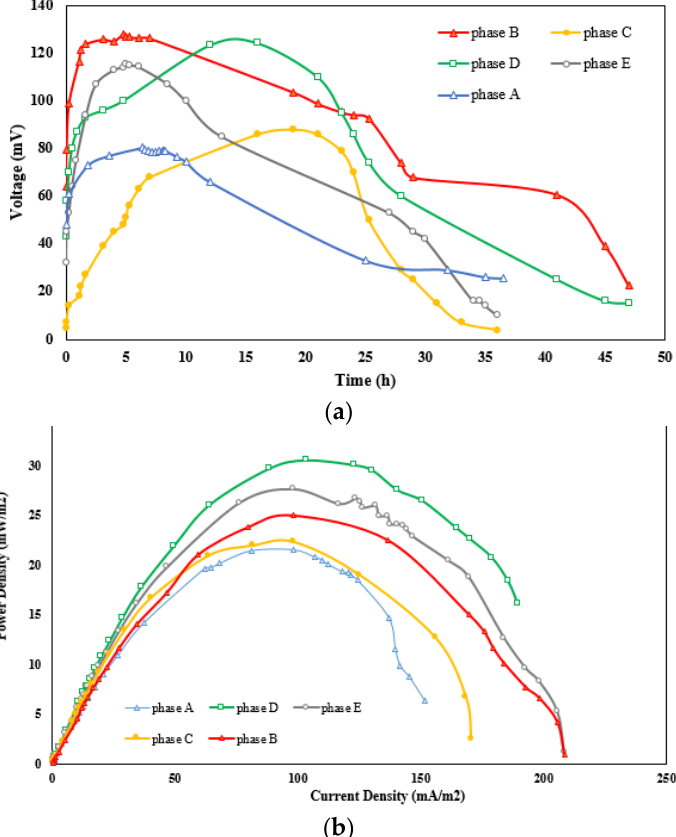
Figure 5. Comparison of different phases: ( a ) interaction between voltage and time; ( b ) interaction between power density and current density.